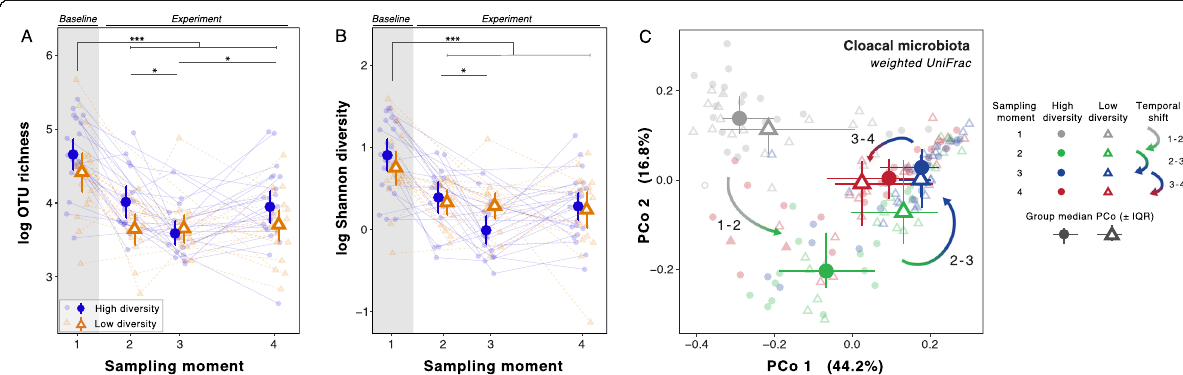
Fig. 2 Experimental and temporal effects on cloacal microbiota alpha diversity and phylogenetic beta diversity. Relationships of population-level variation (mean ± 95% CI whiskers) of ( a ) dominant OTU richness and ( b ) Shannon diversity for each experimental treatment and across sampling moments. c PCoA of weighted UniFrac distances among cloacal microbiota samples; ordination of all samples including baseline samples shows differential clustering of experimental treatment (closed circle = high diversity, open triangle = low diversity) and sampling moments (colors), as well as a pattern of transitions (bicolored arrows) that first diverges from and later converges toward the baseline state. Group medians and IQR are shown as large symbols and whiskers. a , b Faded blue closed circles (high diversity) and orange open triangles (low diversity) represent individual measurements connected by a line per individual (faded solid blue = high diversity, faded dashed orange = low diversity). Experimental treatments are taken simultaneously but split along x-axis for visual clarity. Grey area highlights the baseline sampling moment. Asterisks above plots denote pairwise contrasts among sampling moments; P or FDR-corrected q < 0.1 *, 0.01 **, 0.001 ***. Statistics are detailed in Tables 3 and 4